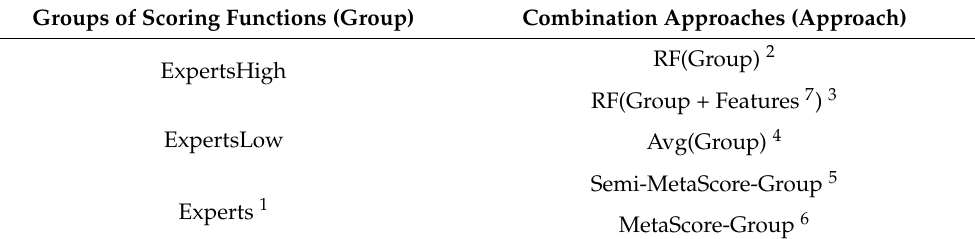
Table 4. Category of scoring method groups and combination approaches for testing MetaScore- Ensemble